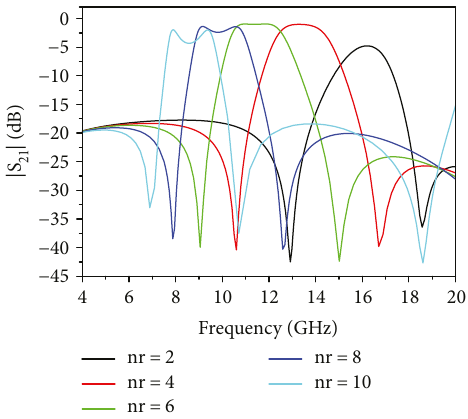
Figure 6: Simulated frequency responses for the fi nger number of interdigital capacitor.